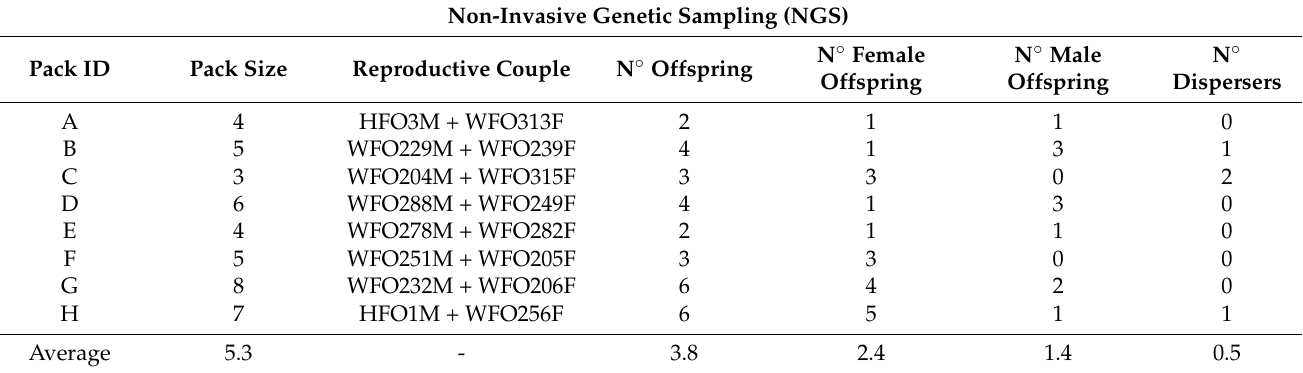
Table 5. Information on packs identified by non-invasive genetic sampling. Non-Invasive Genetic Sampling